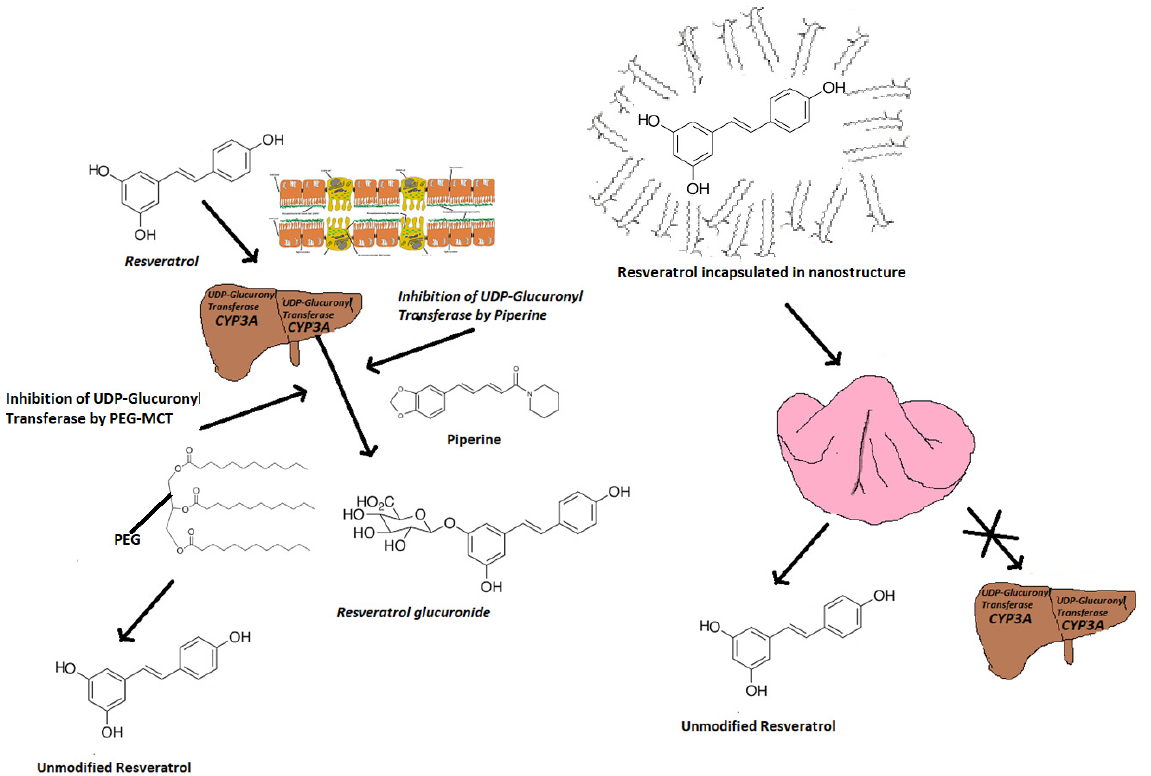
Figure 2. Scheme describing different metabolic pathways of t ‐ Res in the presence of UDPGT inhibitors through the enteric ( left ) and sublingual ( right : with colour pink is represented the tongue) route.